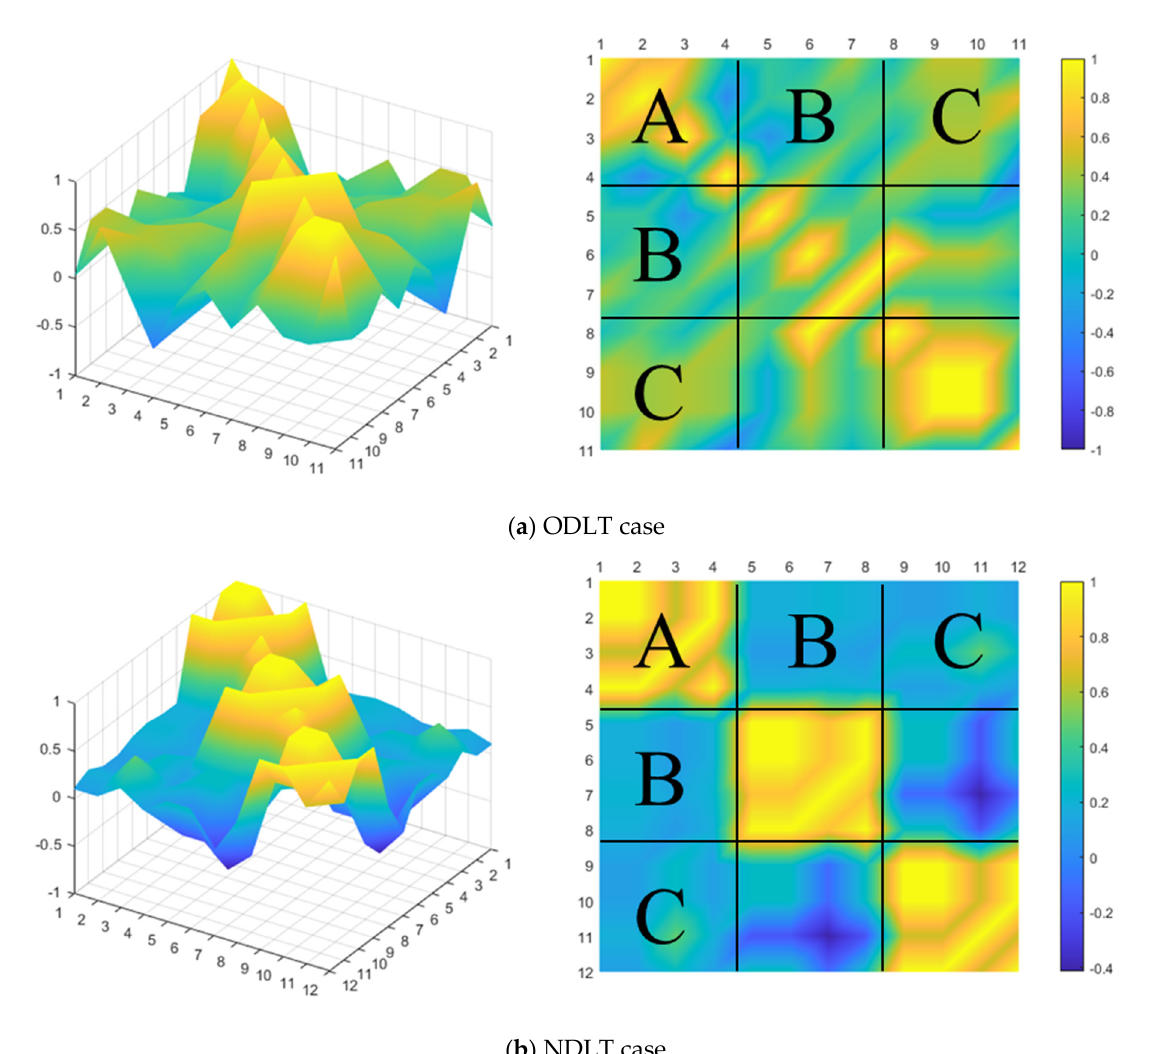
Figure 14. Visualizing the correlation of the DLT parameters.